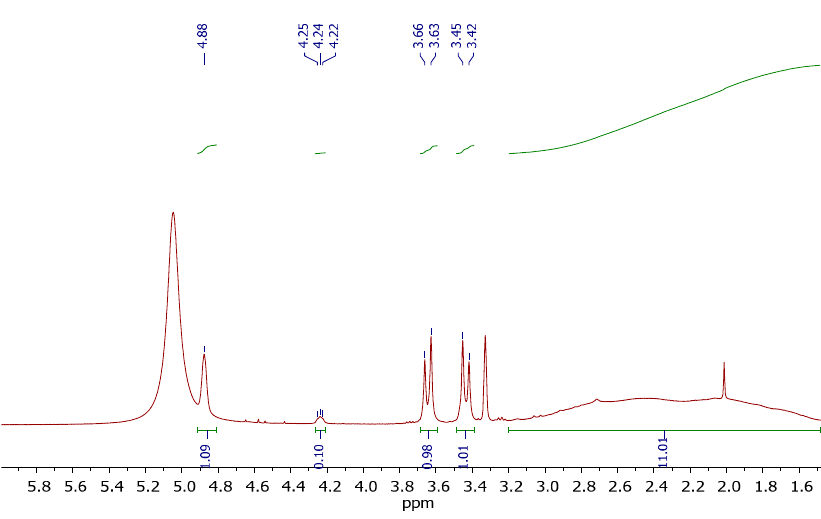
Figure 7. 1 H NMR spectrum of 11 in methanol-d 4.